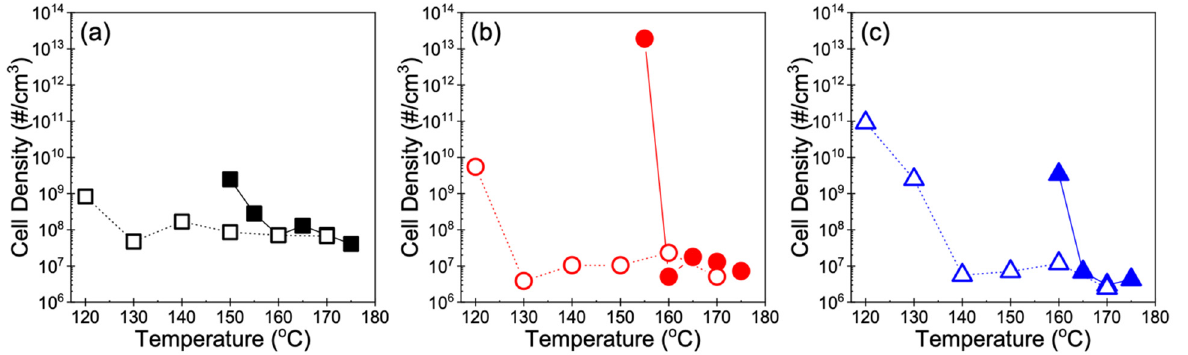
Figure 9. Cell density of ( a ) Resin A, ( b ) Resin B, and ( c ) Resin C foams. Units of cell density correspond to number (#) of nucleated bubbles per volume of foamed polymer. Closed and open symbols (with lines as a guide to the eye) correspond to cell density measurements obtained from foams produced using Method 1 and Method 2, respectively.